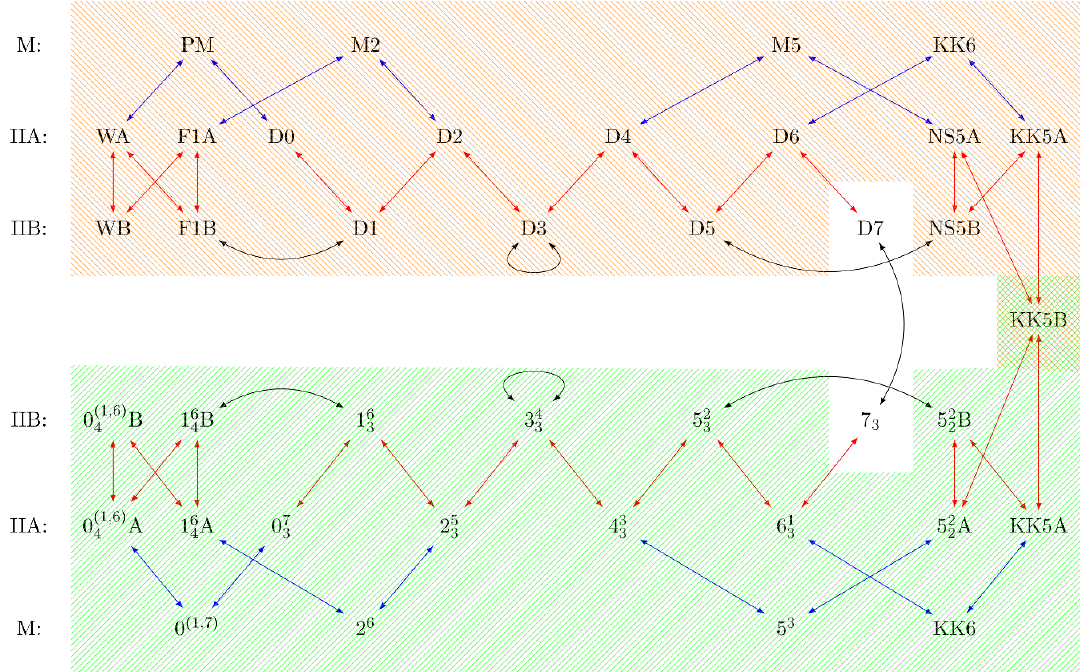
Figure 1 . The branes that we consider. Red lines denote T-duality, blue lines denote lifts/reductions and black lines denote S-dualities. The hashed green area contains all the branes contained within this non-geometric solution whilst the hashed orange area contains all the branes contained in the geometric